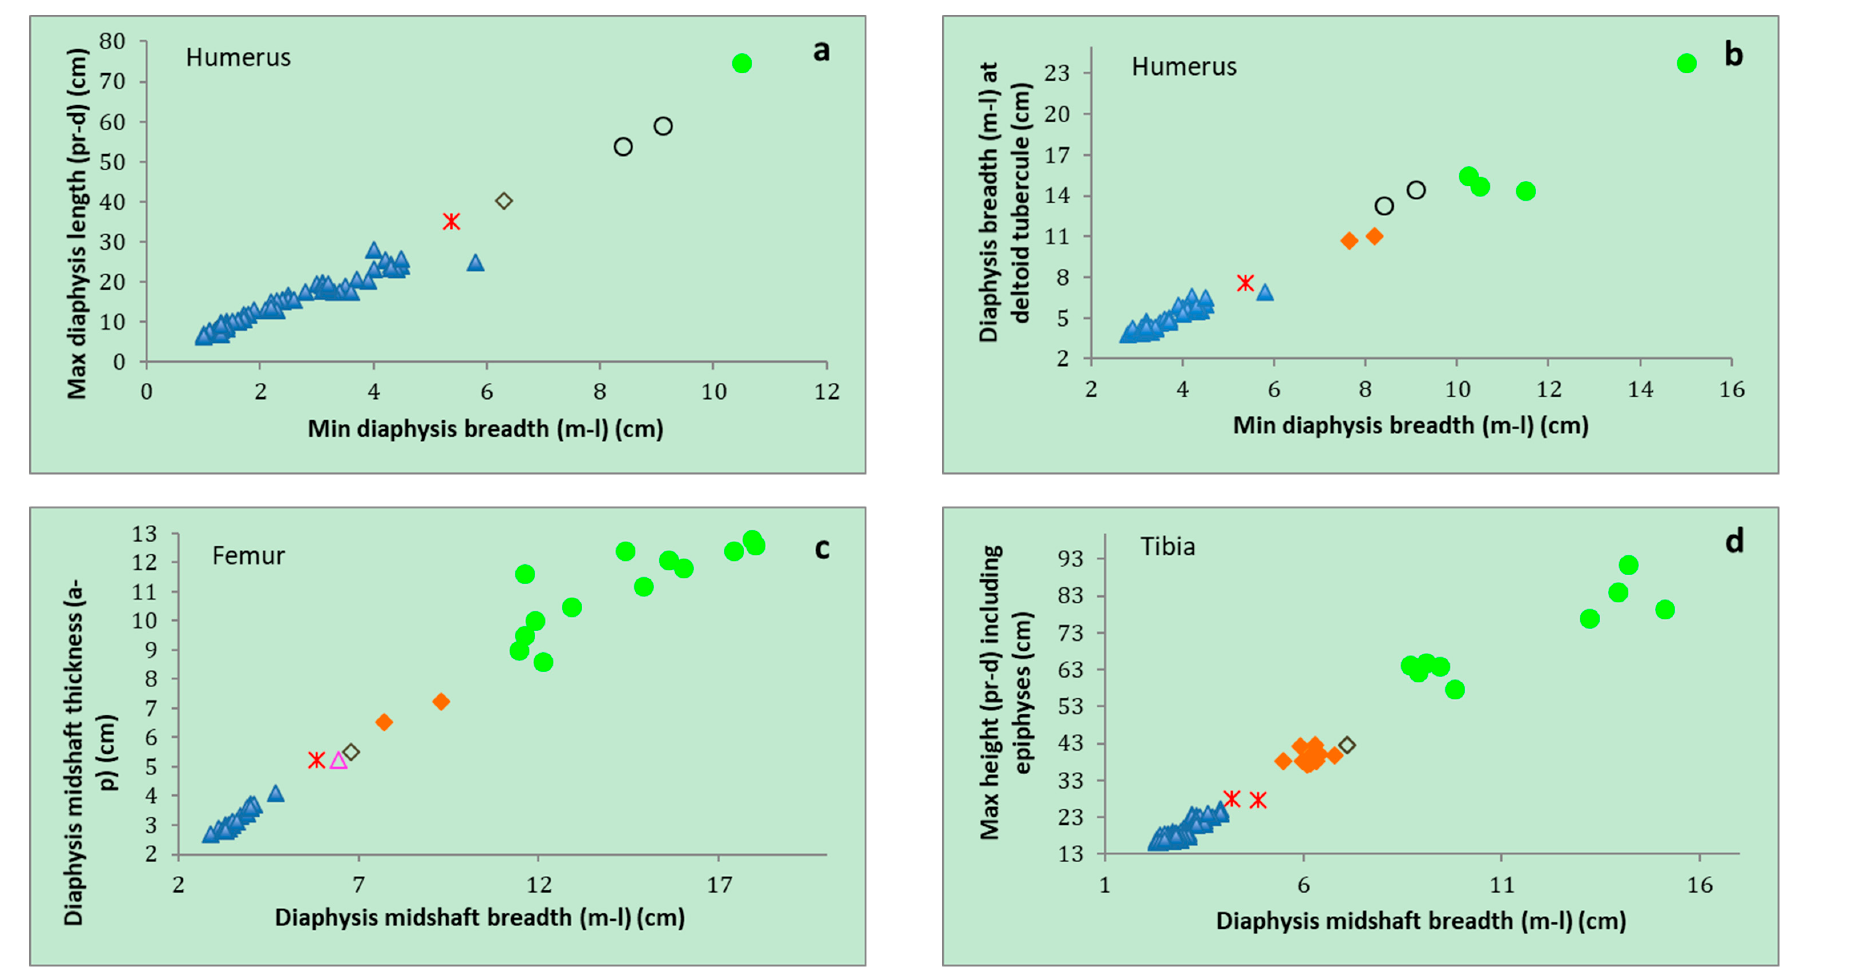
Figure 3. Scatterplot of the dimensions of the foot bones ( a ) Max breadth of astragalus (m-l) vs. articular facet for navicular (a-p). ( b ) Figure legend. ( c ) Intermediate carpal max breadth (m-l) vs. max thickness (a-p). ( d ) Ulnar carpal max breadth vs. max anterior height. Data sources: P. antiquus from Palombo et al., unpublished. All remaining data are original.